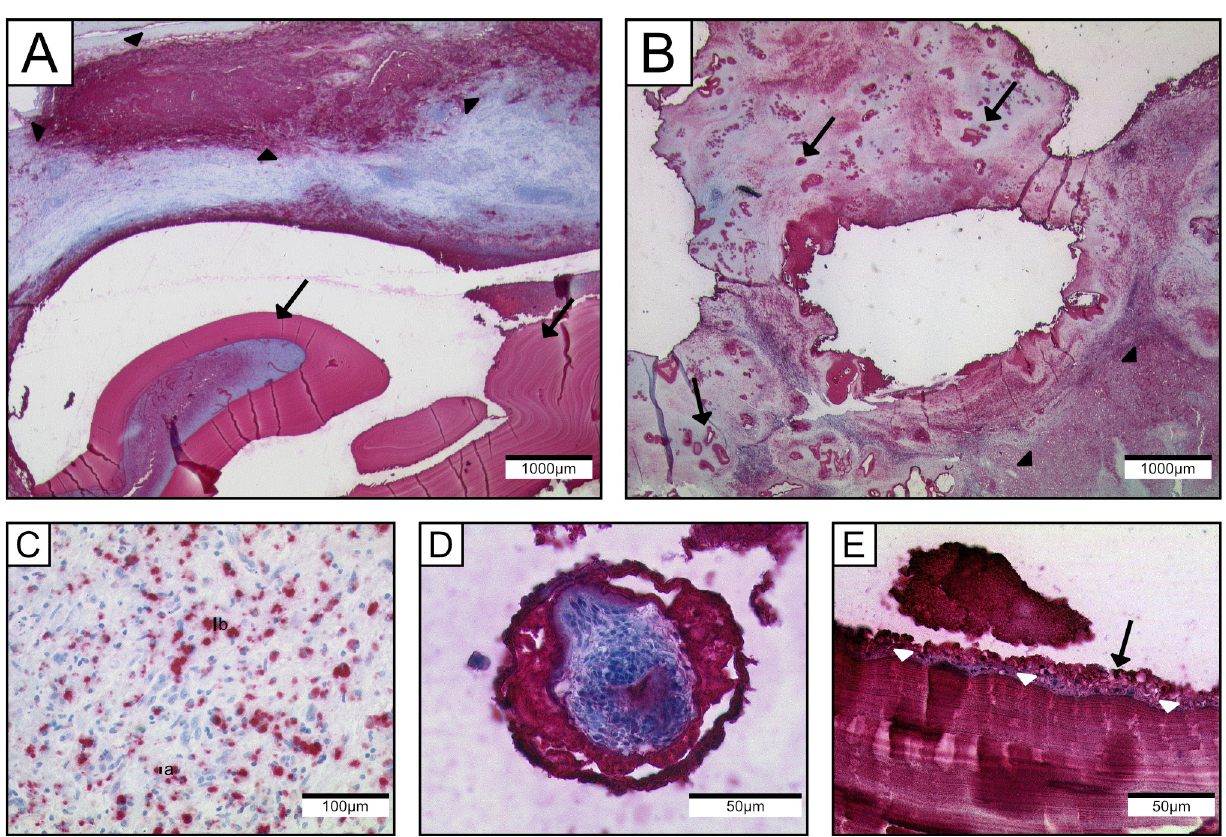
Fig 1. Staining pattern of mAb EmG3 on echinococcus metacestodes. mAb EmG3-IHC: (A) CE lesion in the lung showing strong positive staining of the laminated layer (arrows), adjacent to the main lesion small particles of E . granulosus s . l . (arrowheads) are strongly immunoreactive. (B) AE in the liver with strongly positive tubular structures presenting the laminated layer (arrows), adjacent to the main lesion small particles of E . multilocularis are strongly positive (arrowheads). (C) Higher magnification of spegs adjacent to the main lesion. Diameter of spegs: (a) 6 μ m (b) 17 μ m; (D) Protoscolex of E . granulosus s . l . with strong positivity in the periphery. (E) High magnification of laminated layer (white arrowheads) and germinal layer (black arrow) of E . granulosus s . l